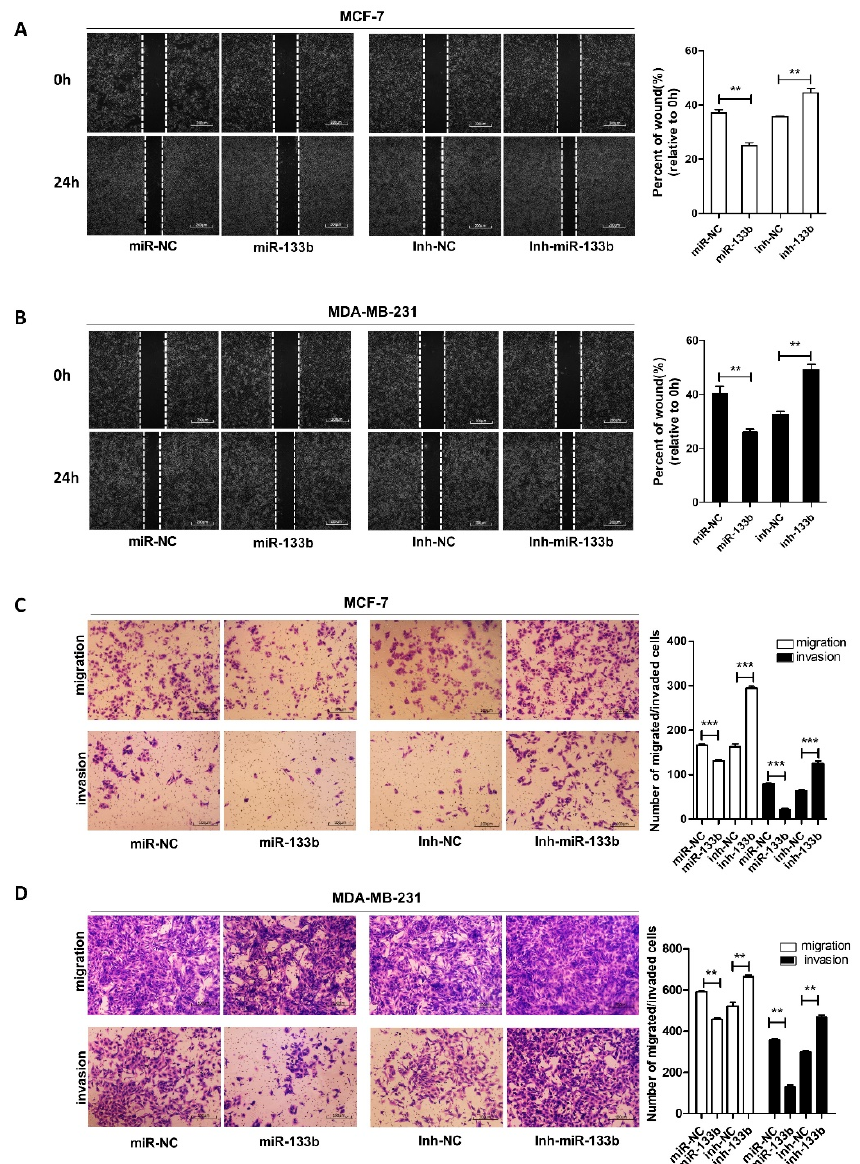
Figure 3. miR-133b promotes breast cancer cells migration and invasion in vitro. ( A , B ) Migration of MCF-7 cells ( A ) and MDA-MB-231 cells ( B ) transfected with mimics NC (miR-NC), miR-133b mimics (miR-133b), inhibitor NC (inh-NC) or miR-133b inhibitor (inh- miR-133b) detected by wound healing assay. Scale bar, 100 µ m. ( C , D ) Migration and invasion of MCF-7 cells ( C ) and MDA-MB-231 cells ( D ) transfected with mimics NC, miR-133b mimics, inhibitor NC or miR-133b inhibitor detected by transwell migration assay and transwell invasion assay. Scale bar, 100 µ m. ** p < 0.01; *** p < 0.001.